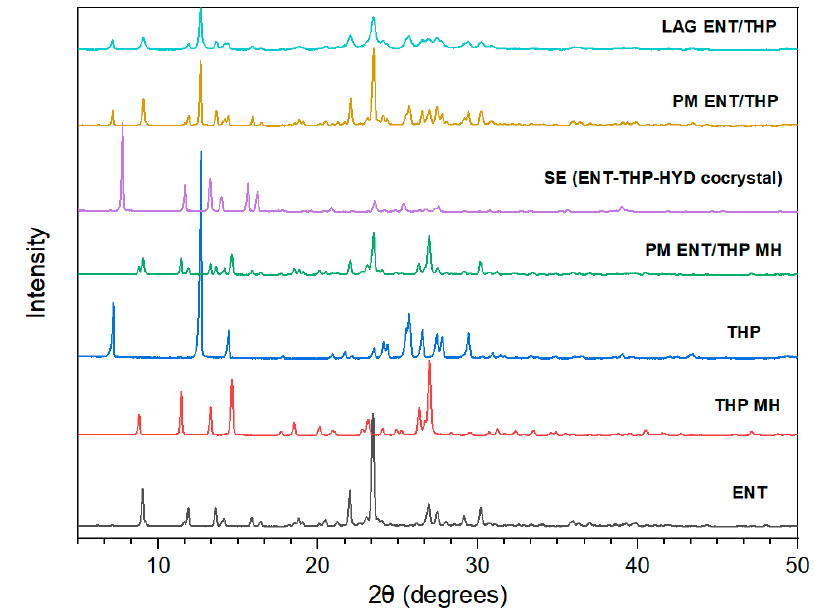
Figure 2. XRPD diffractograms for the neat components, physical mixtures (PM), and cocrystal. ENT-THP-water cocrystal was obtained with solvent evaporation (SE) in environmental conditions, from ENT solutions with THP monohydrate or anhydrous THP.